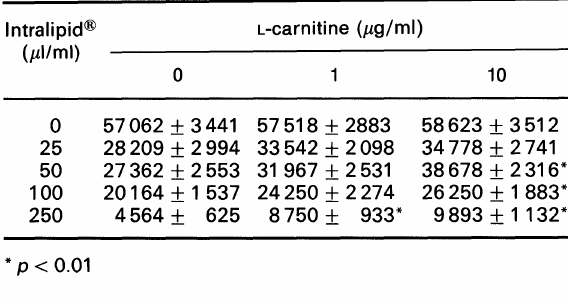
Table 1. Effect of Intralipid (R) and Intralipid (R) plus L-carnitine on PHA-driven PBMC proliferation. The results are shown